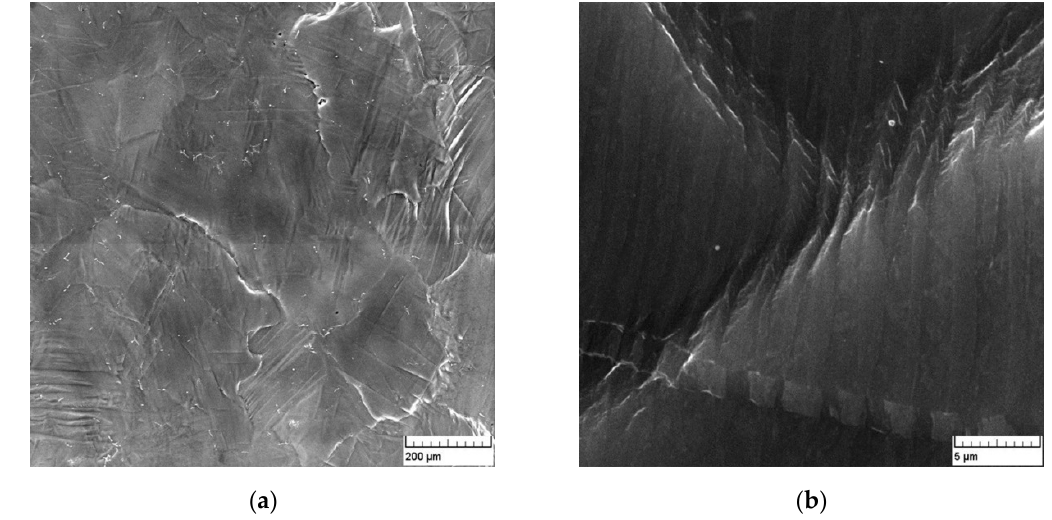
Figure 13. Microstructure of the deformed AZ31 alloy containing many deformation bands. ( a ) Deformation bands of two slip systems in particular bands. ( b ) Fine structure of the strain band.